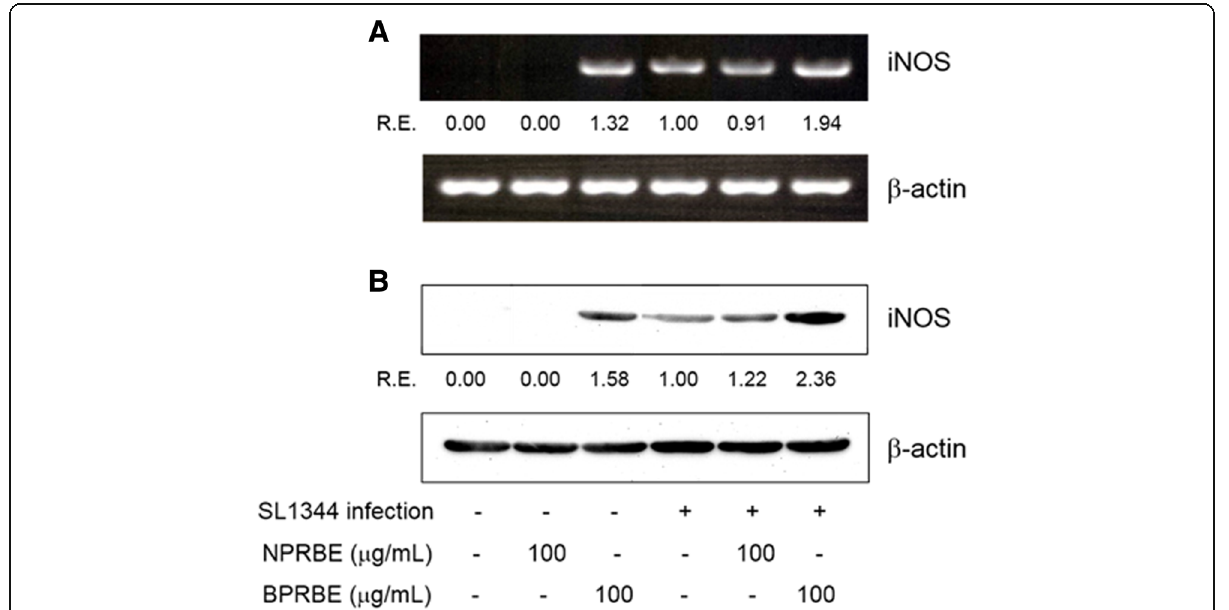
Fig. 2 Effects of BPRBE on iNOS gene expression in S. Typhimurium-infected macrophages. a iNOS mRNA expression profiles assessed by RT-PCR. RAW 264.7 cells were cultivated with or without BPRBE for 24 h. The cells were then infected with S. Typhimurium SL1344 for 8 h. After infection, total RNA was purified and an iNOS mRNA expression profile was determined using RT-PCR analysis. b Assessment of iNOS protein expression profiles by Western blot analysis. RAW 264.7 cells treated with BPRBE for 24 h and then infected with S. Typhimurium were lysed and the iNOS protein in the cell lysate was then identified by Western blotting using rabbit anti-mouse iNOS polyclonal antibody. The relative proportions of iNOS mRNA and polypeptide are expressed as the R. E. (relative expression) values calculated from iNOS/ β -actin gene expressions. Figures represent results from at least three individual